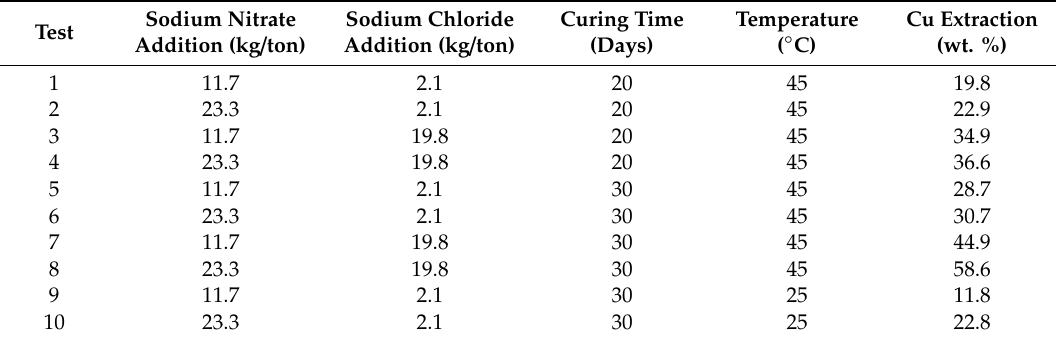
Table 5. Pretreatment tests and maximum copper extraction (wt. %).